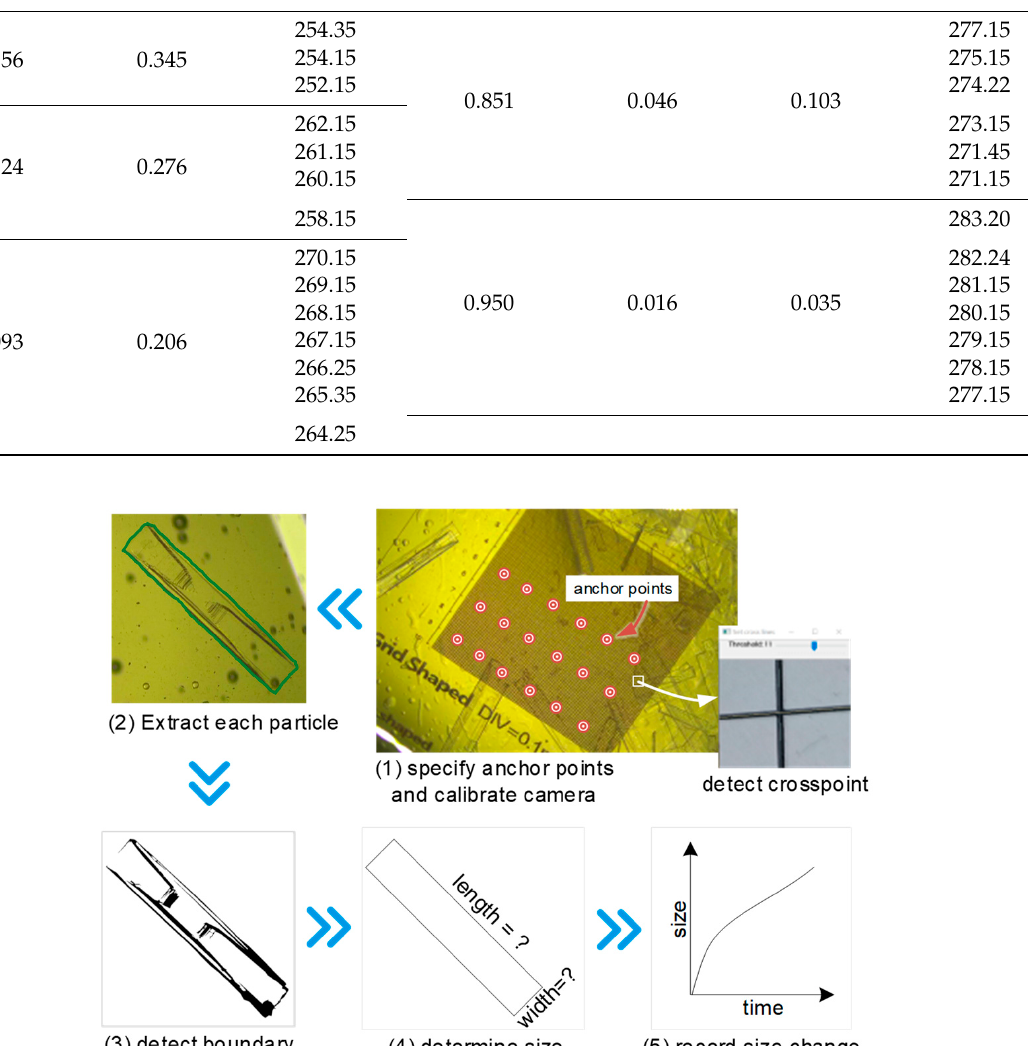
mination. It was a grid-lined piece of paper measuring 1 cm × 1 cm, with lines at intervals